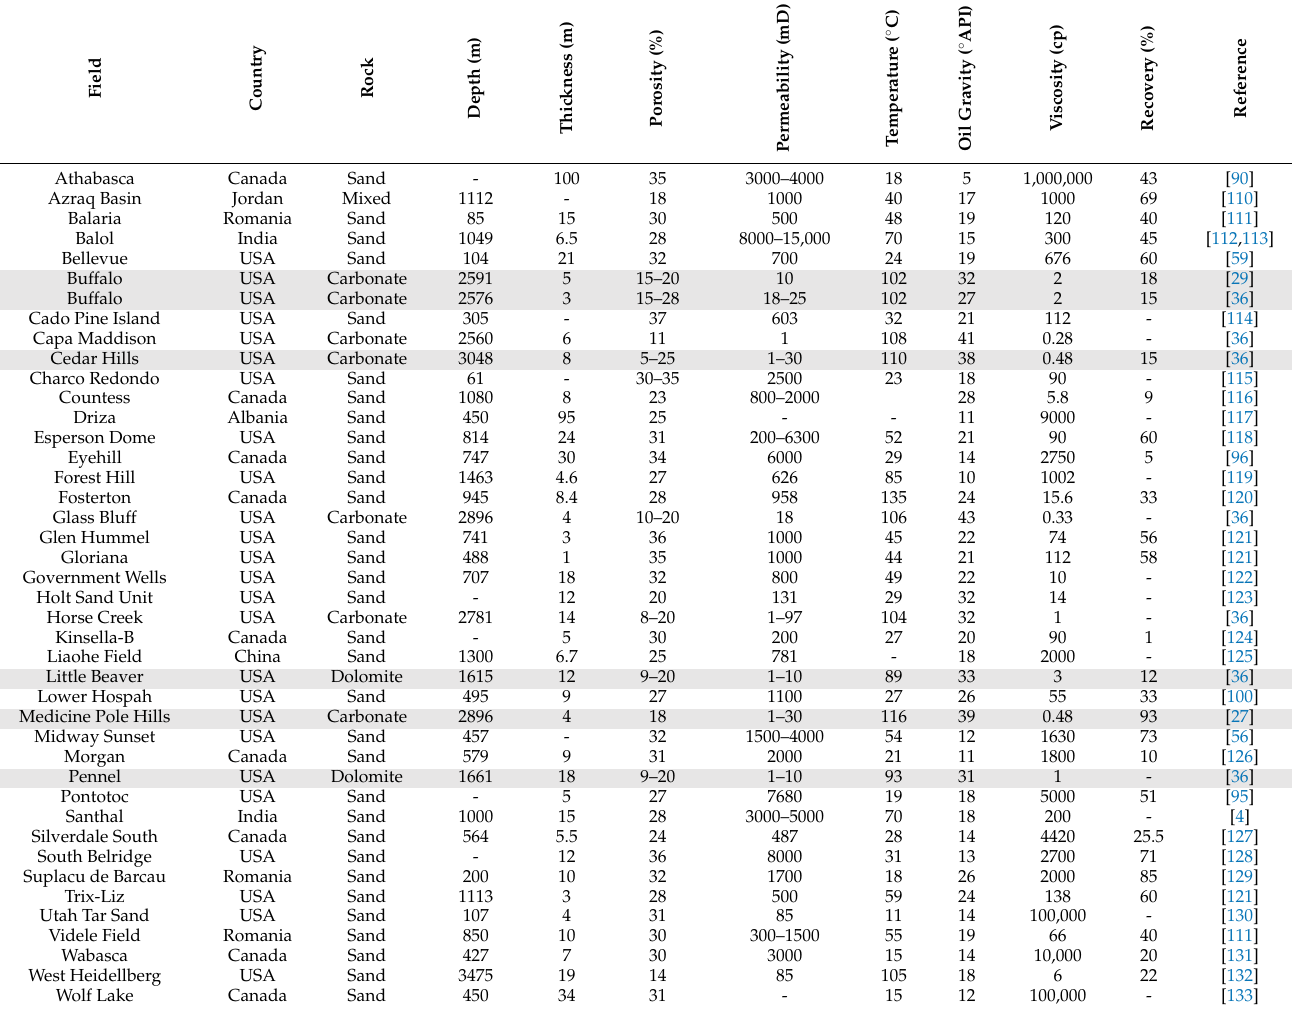
Table 1. Table of reservoir and oil properties from reported in-situ combustion (ISC) and high- pressure air injection (HPAI) projects in the literature. Reported properties are rock type, maximum depth, maximum thickness, porosity, permeability, reservoir temperature, oil gravity, oil viscosity, and oil recovery as a percent of oil originally in place. All active projects are shaded grey as listed by the IEA International Energy Agency [97].